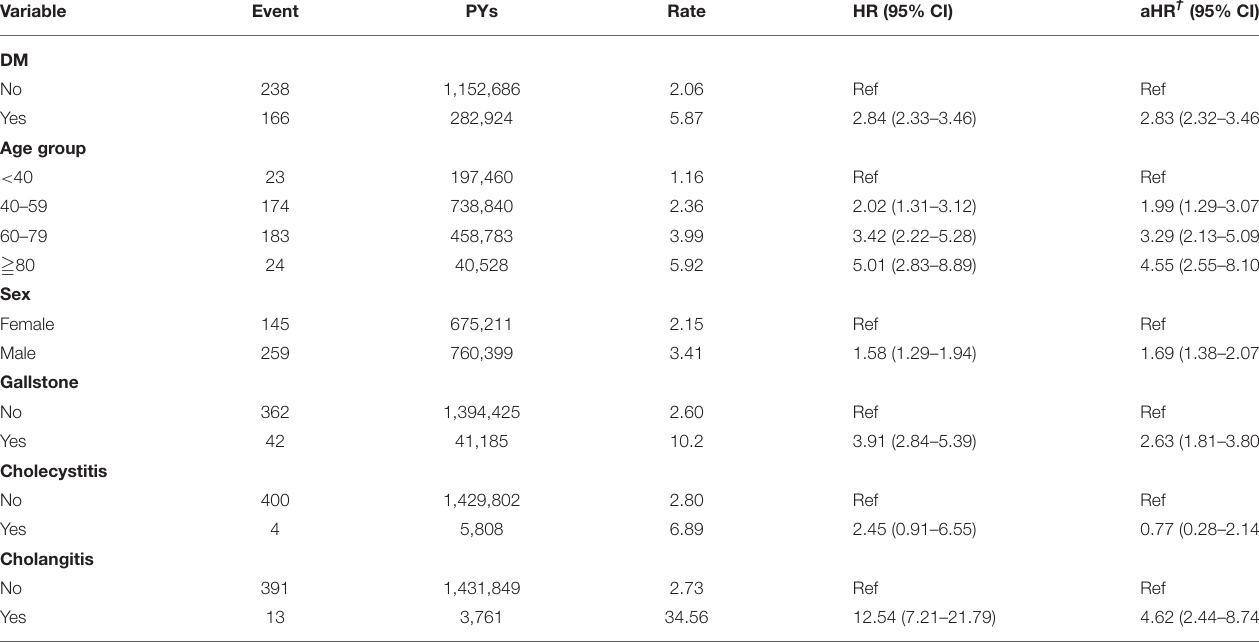
TABLE 2 | HRs and adjusted HRs for PLA in the study cohort.